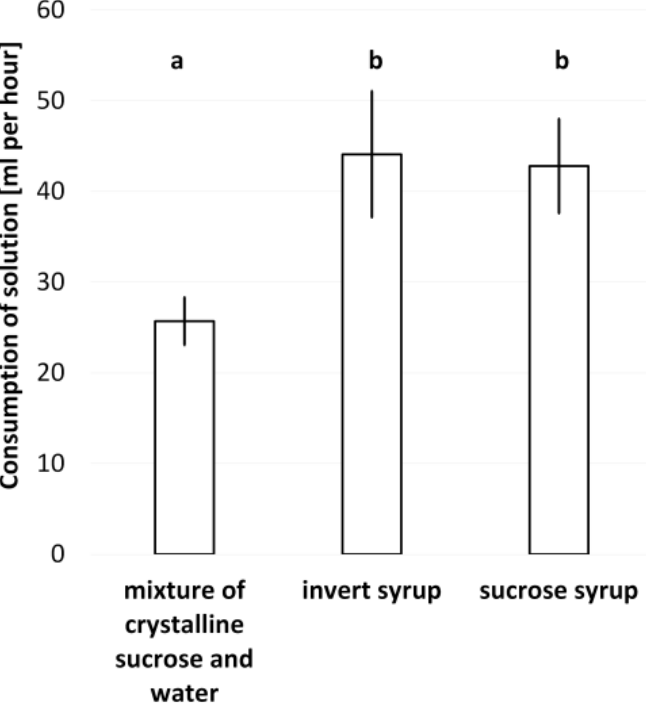
Figure 1. Time needed for intake of a given feed. Means ± SD (bars) and different letters indicate significant differences in consumption speed (Tukey’s test p < 0.01).